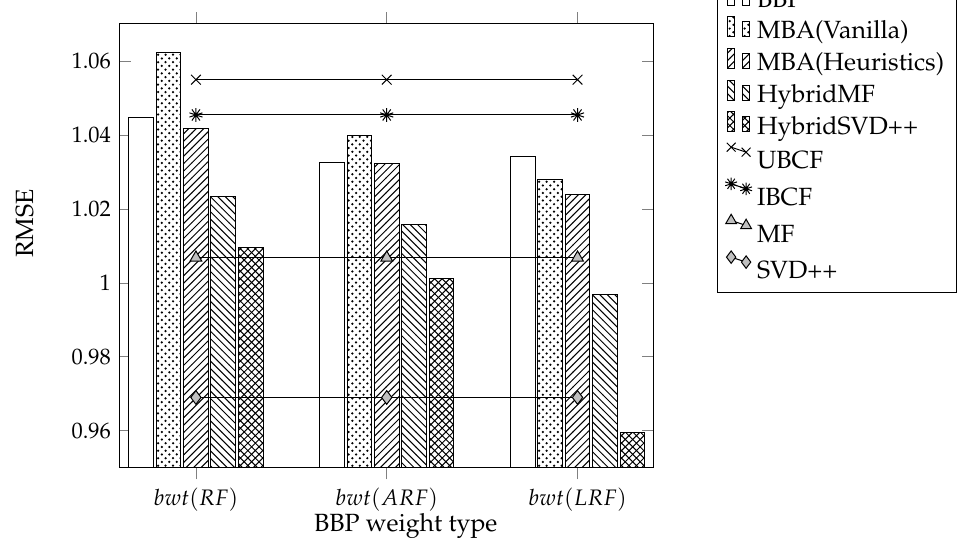
Figure 5. Comparison of